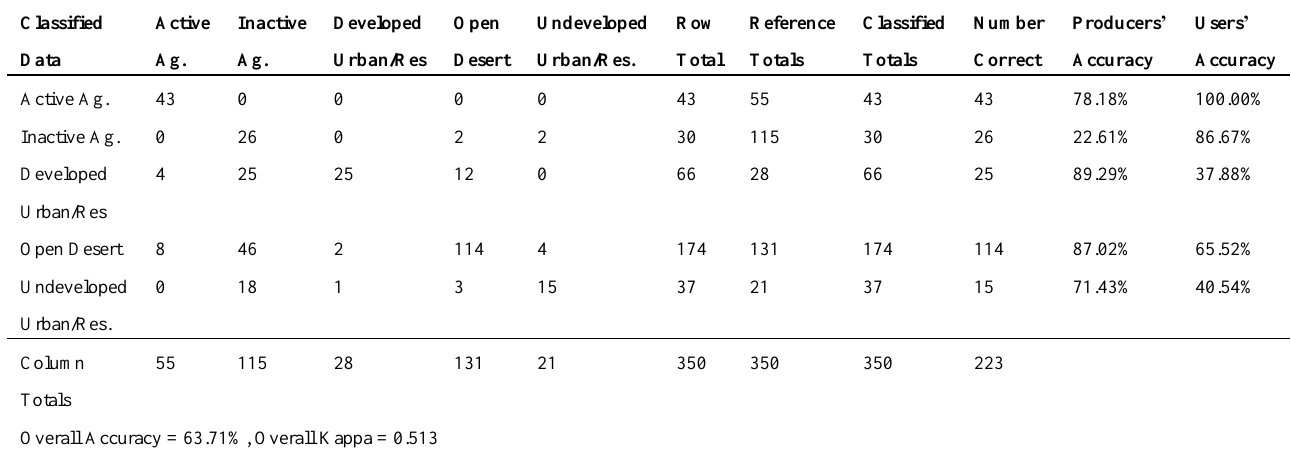
Table 4. Error matrix and classification accuracy—Supervised